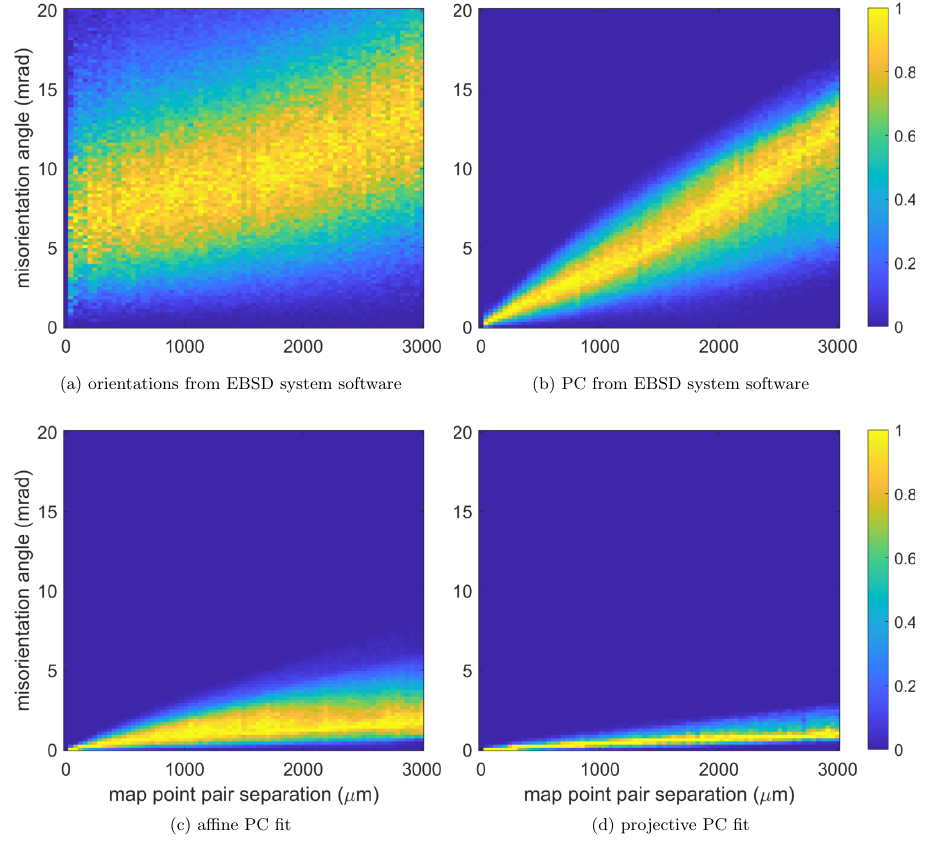
Figure 7. Distributions of the relative misorientation angle between pairs of map points, as a function of the map point pair separation for different projection center models. ( a ) raw orientations as given by the EBSD system software, ( b ) refined orientations by pattern matching using the PC calibration of the EBSD system software, ( c ) refined orientations using the affine PC calibration, ( d ) refined orientations using the projective PC calibration. The distributions are normalized to the maximum value of the misorientation angle distribution at each distance (bin width 40 µ